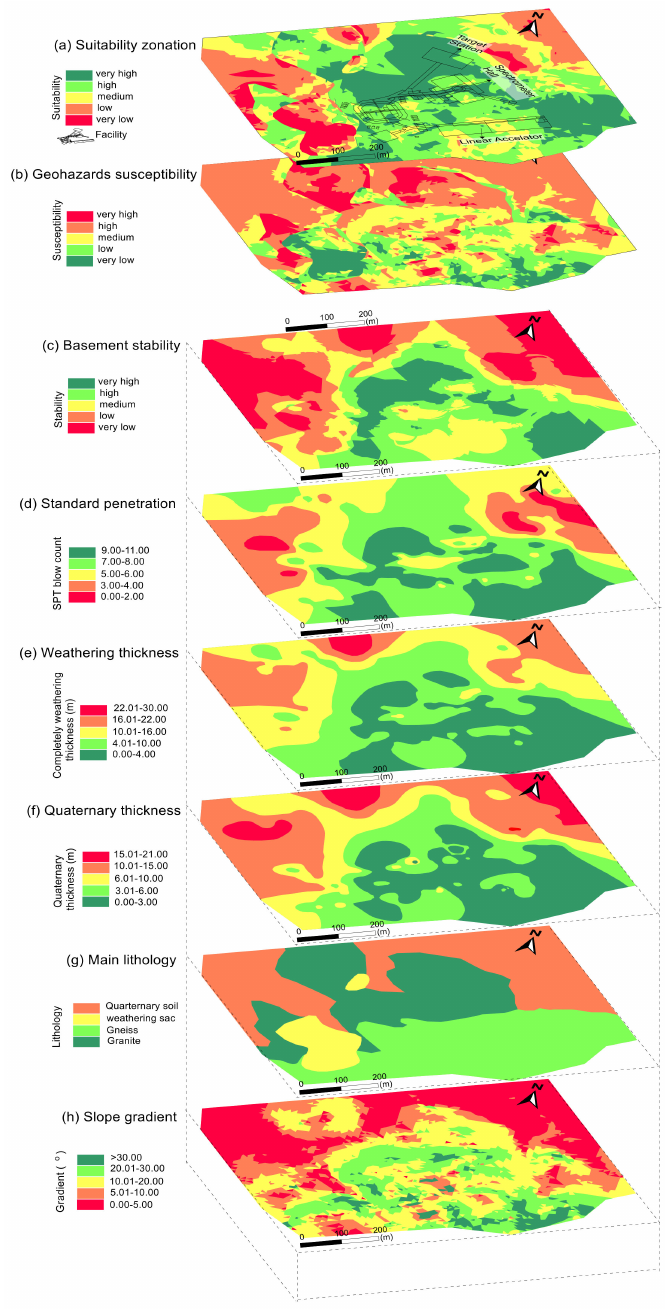
Figure 4. Geological suitability zonation at the CSNS site for different indices, such as ( a ) suitability zonation, ( b ) geohazards susceptibility, ( c ) basement stability, ( d ) standard penetration, ( e ) weathering thickness, ( f ) quaternary thickness, ( g ) main lithology, and ( h ) slope gradient at the CSNS